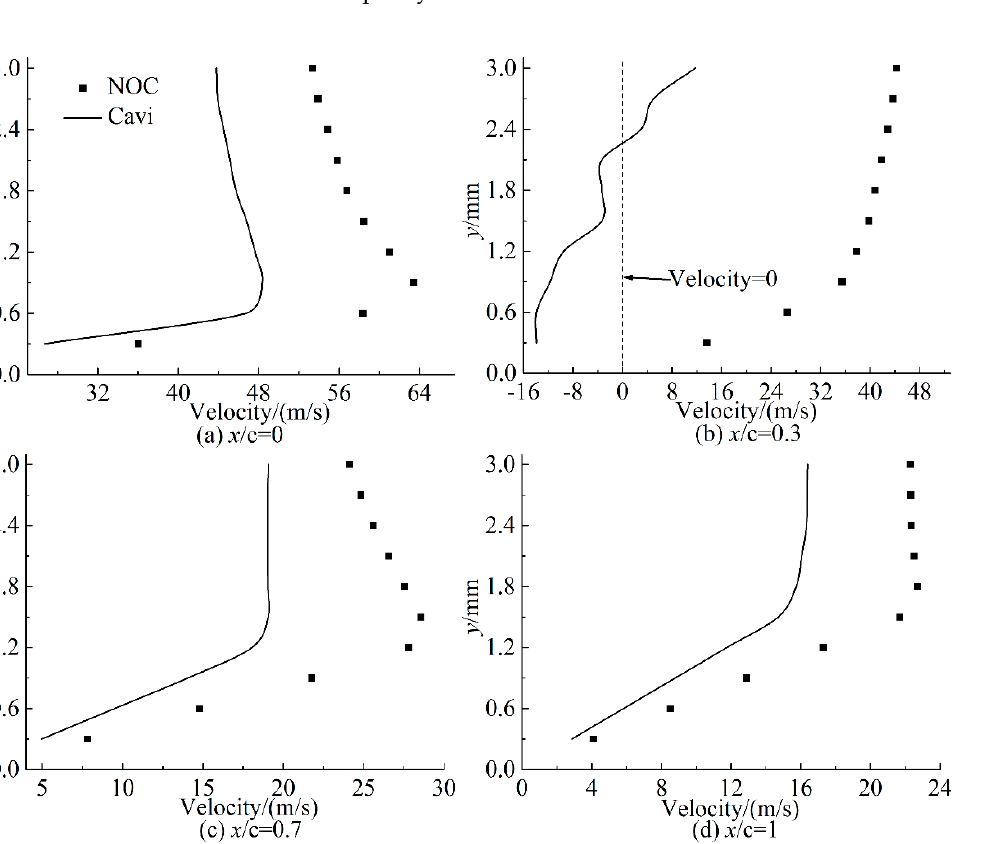
Figure 16. Normal velocity distributions at selected monitoring locations along the suction side of the stator under non-cavitation and cavitation conditions ( SR = 0).